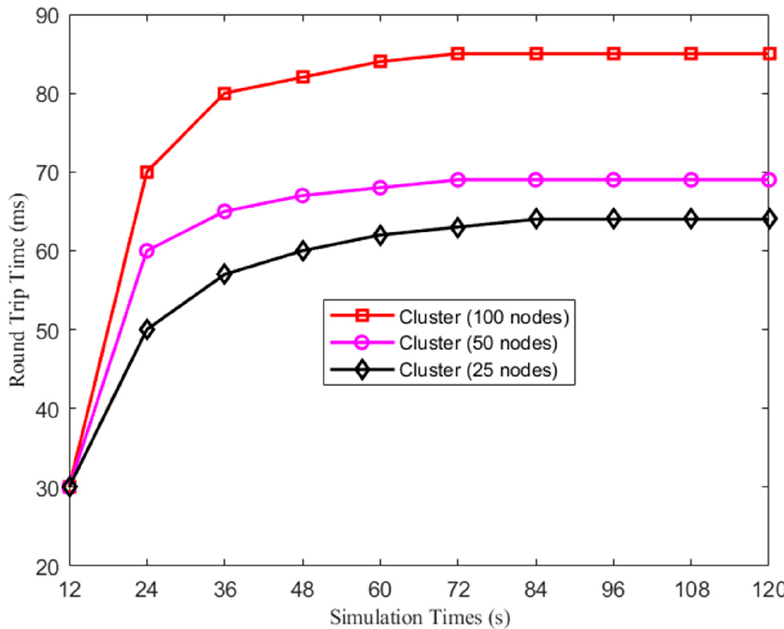
Figure 9. Round trip time comparison among 25, 50, and 100 nodes.